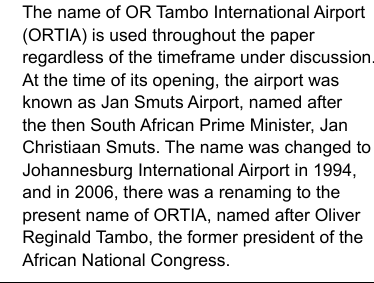
Railway Line Major Road Figure 1: OR Tambo airport-centric development Source: Adapted from Mokhele, 2016: